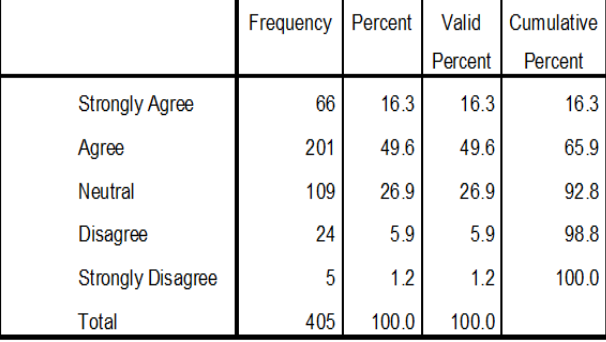
Figure 11. the Company’s profits have improved as indicated by higher amounts of resource